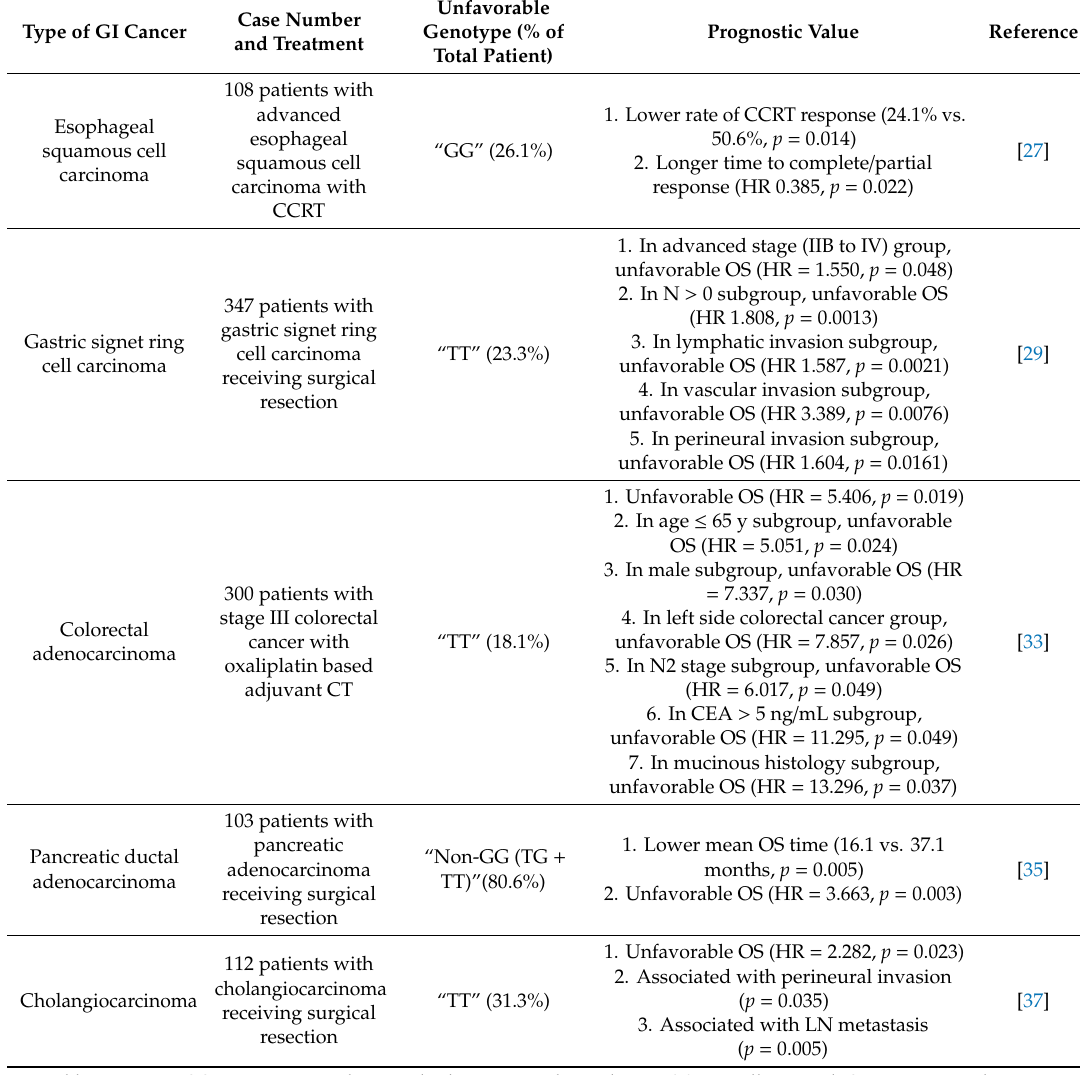
Table 2. GALNT14-rs9679162 SNP in di ff erent gastrointestinal (GI)